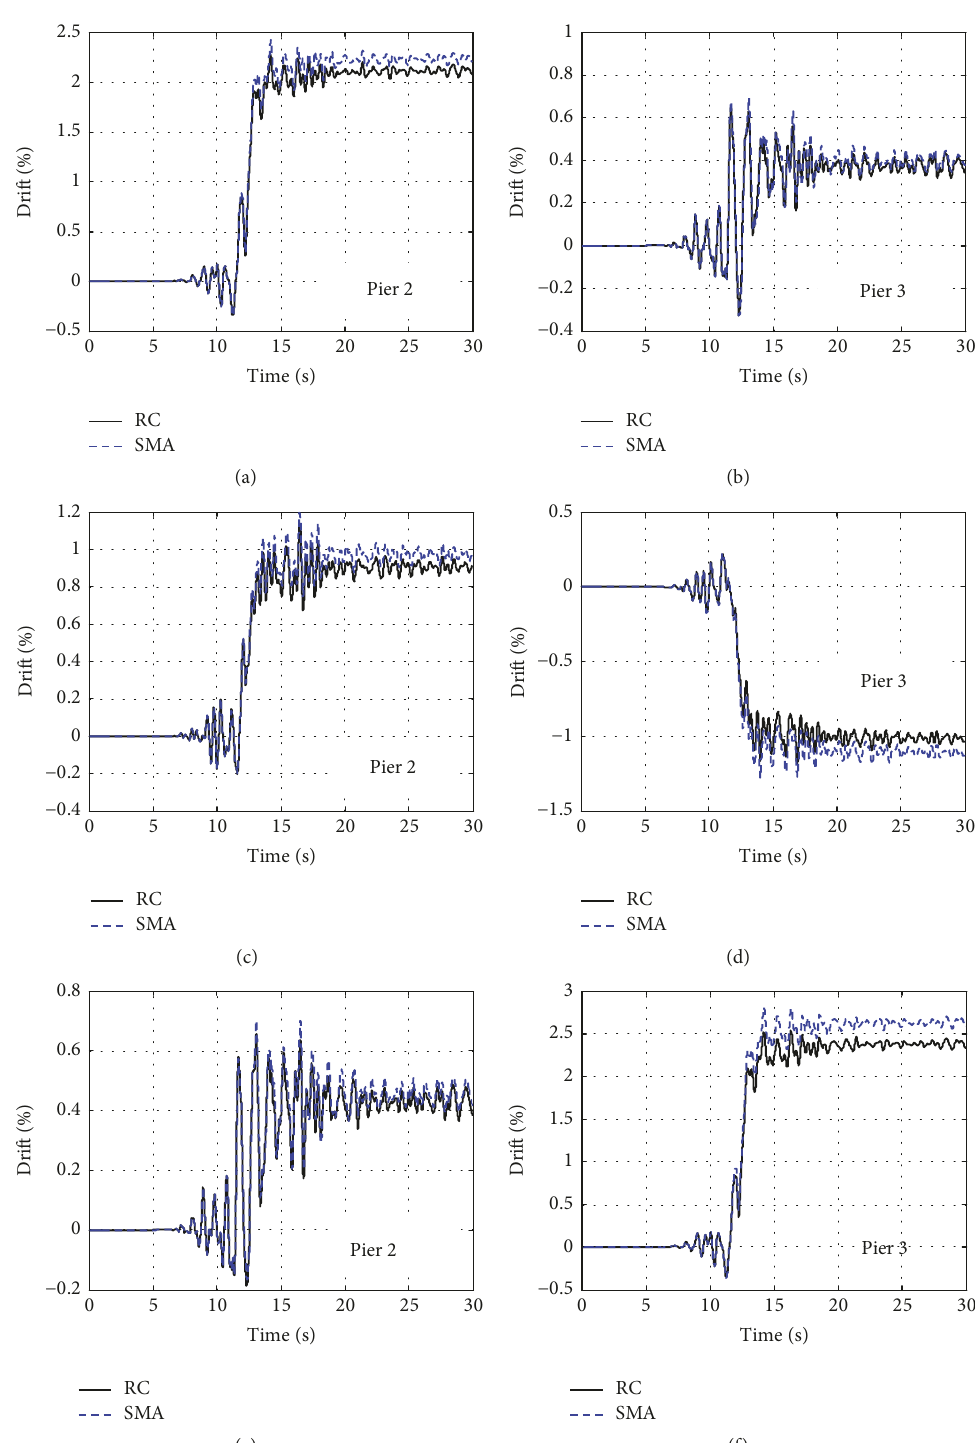
Figure 12: Displacement history of the top column: (a) Pier 2 in Case 1, (b) Pier 3 in Case 1, (c) Pier 2 in Case 2, (d) Pier 3 in Case 2, (e) Pier 2 in Case 3, and (f) Pier 3 in Case